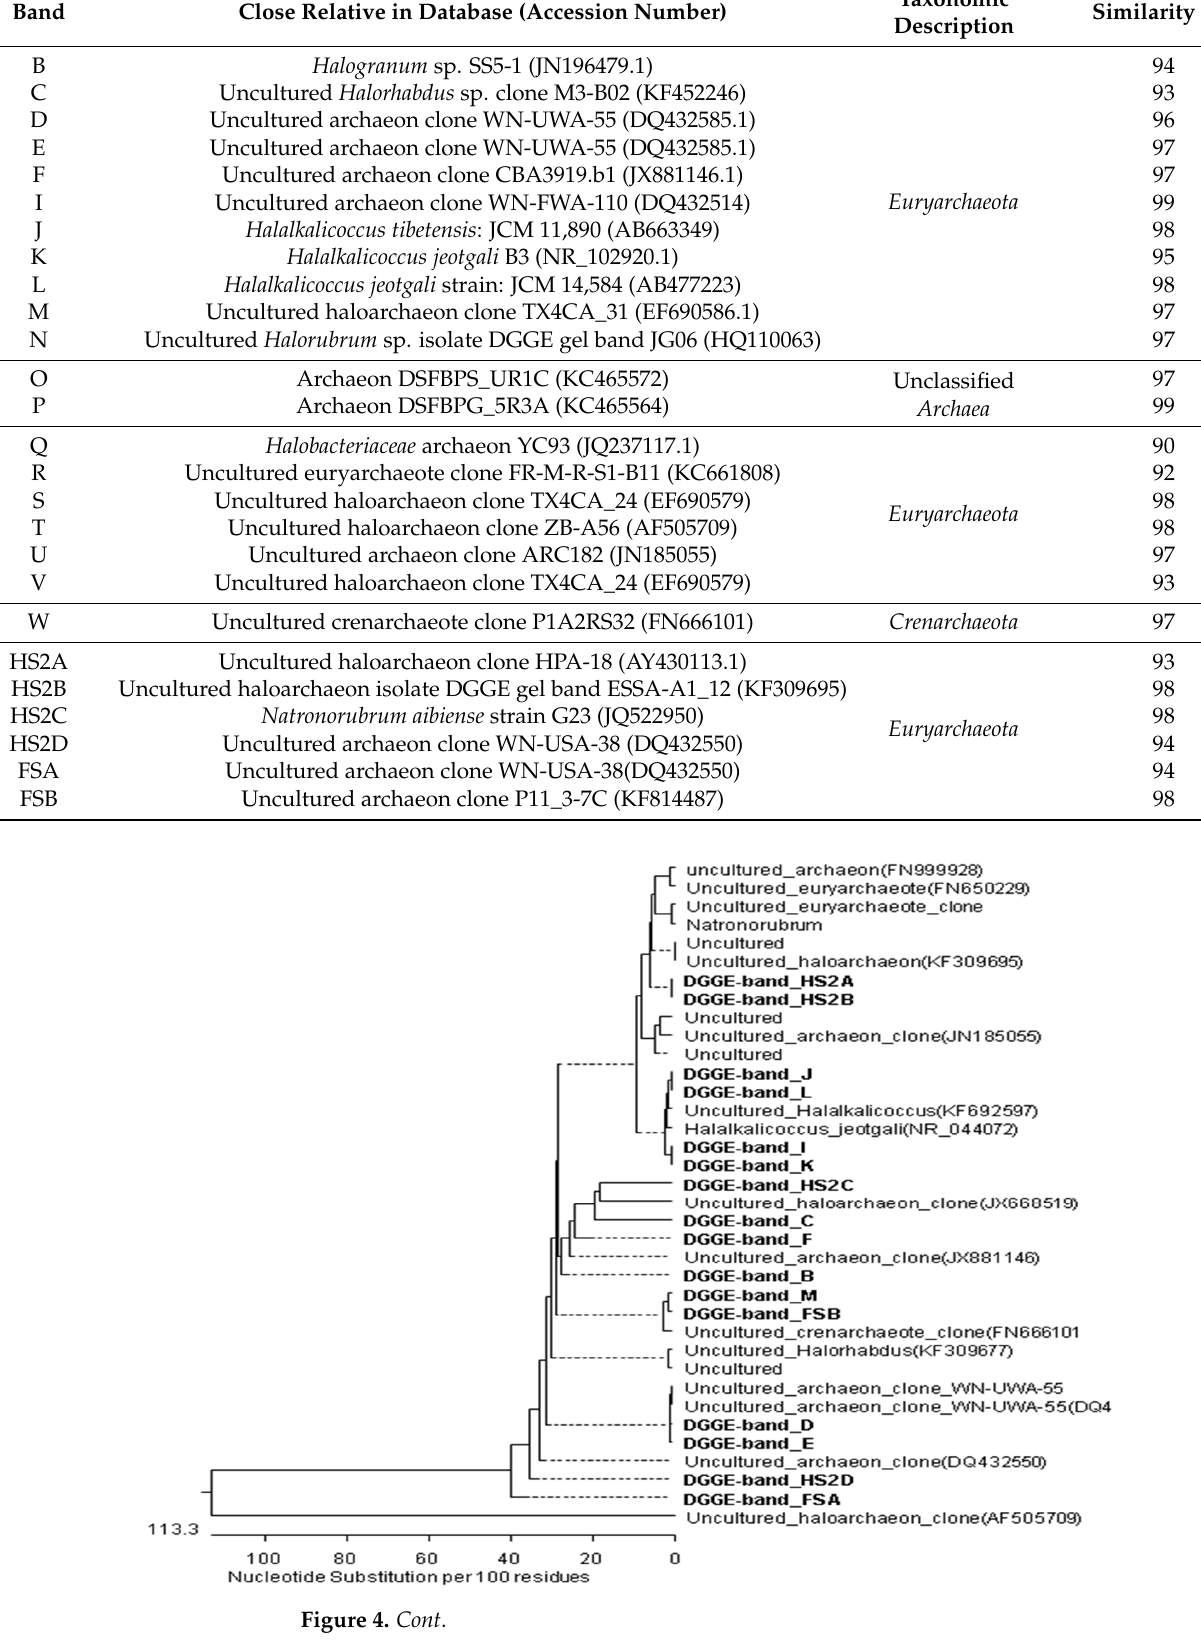
Figure 4. Phylogenetic tree showing the relationships of archaeal 16S rRNA gene sequences of ex- cised DGGE bands to closely related (S ≥ 90%) sequences from the GenBank database. 3.3. Spatial Distribution of Archaeal DNA by GIS and Remote Sensing Remote sensing and GIS are highly accepted techniques for monitoring lake surfaces and detection of changes [5,68–70]. In this survey, the obtained map after classification discriminated the four analyzed lakes into three different areas, namely water (deep and shallow zones), salts and soil. This classification depends on the reflectance of each of these features according to a suitable threshold (Figure 5).